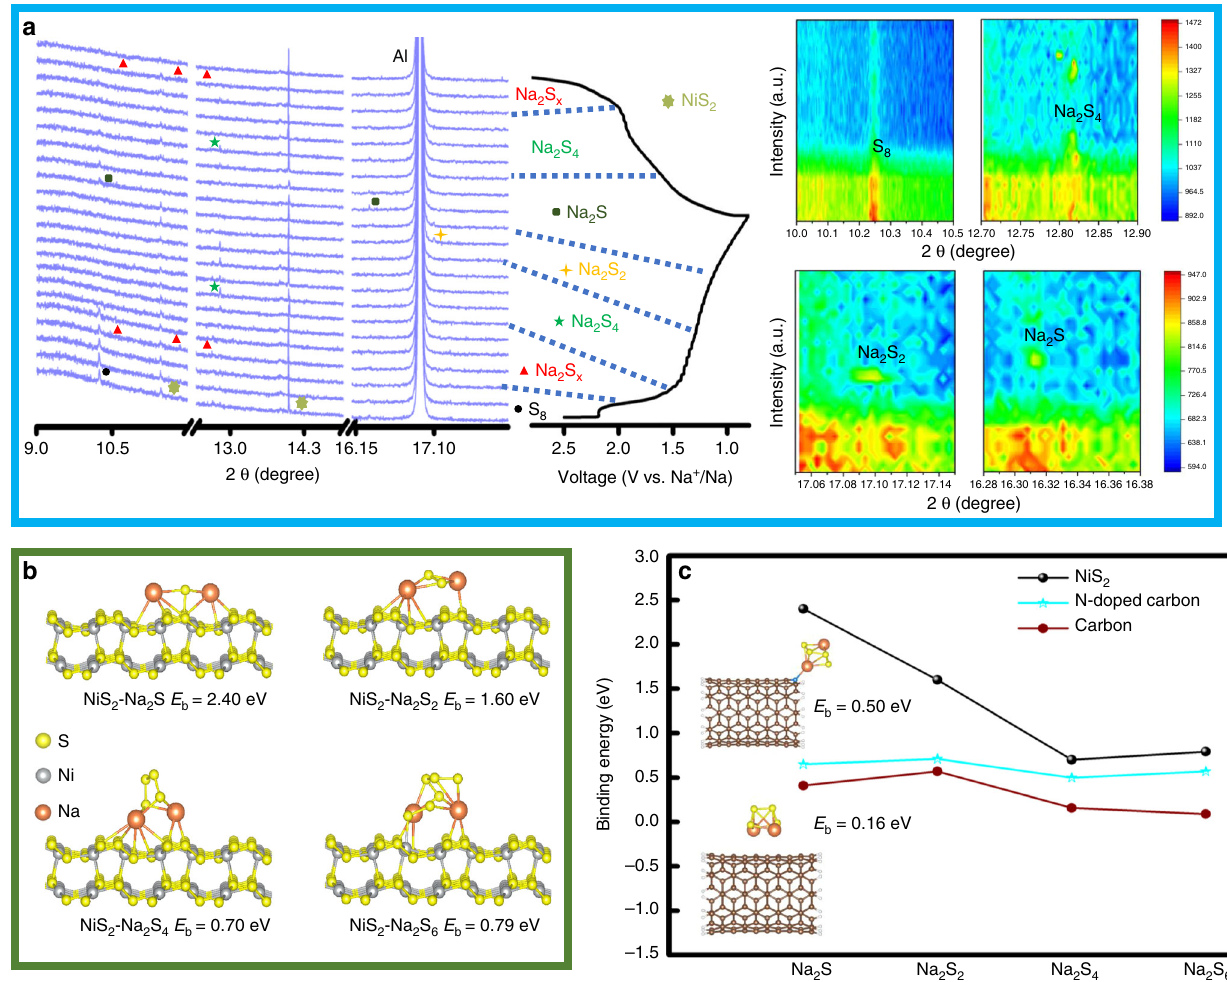
Fig. 4 Characterization of mechanism. a In situ synchrotron XRD patterns of the RT-Na/S battery containing a NiS 2 @NPCTs/S electrode with the corresponding galvanostatic charge/discharge curves at the current density of 200 mA g − 1 , and contour plot of XRD patterns in selected ranges